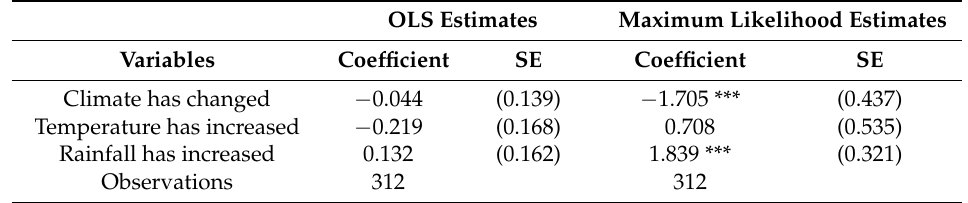
Table 4. The impact of climate change perceptions on the index of SAPs